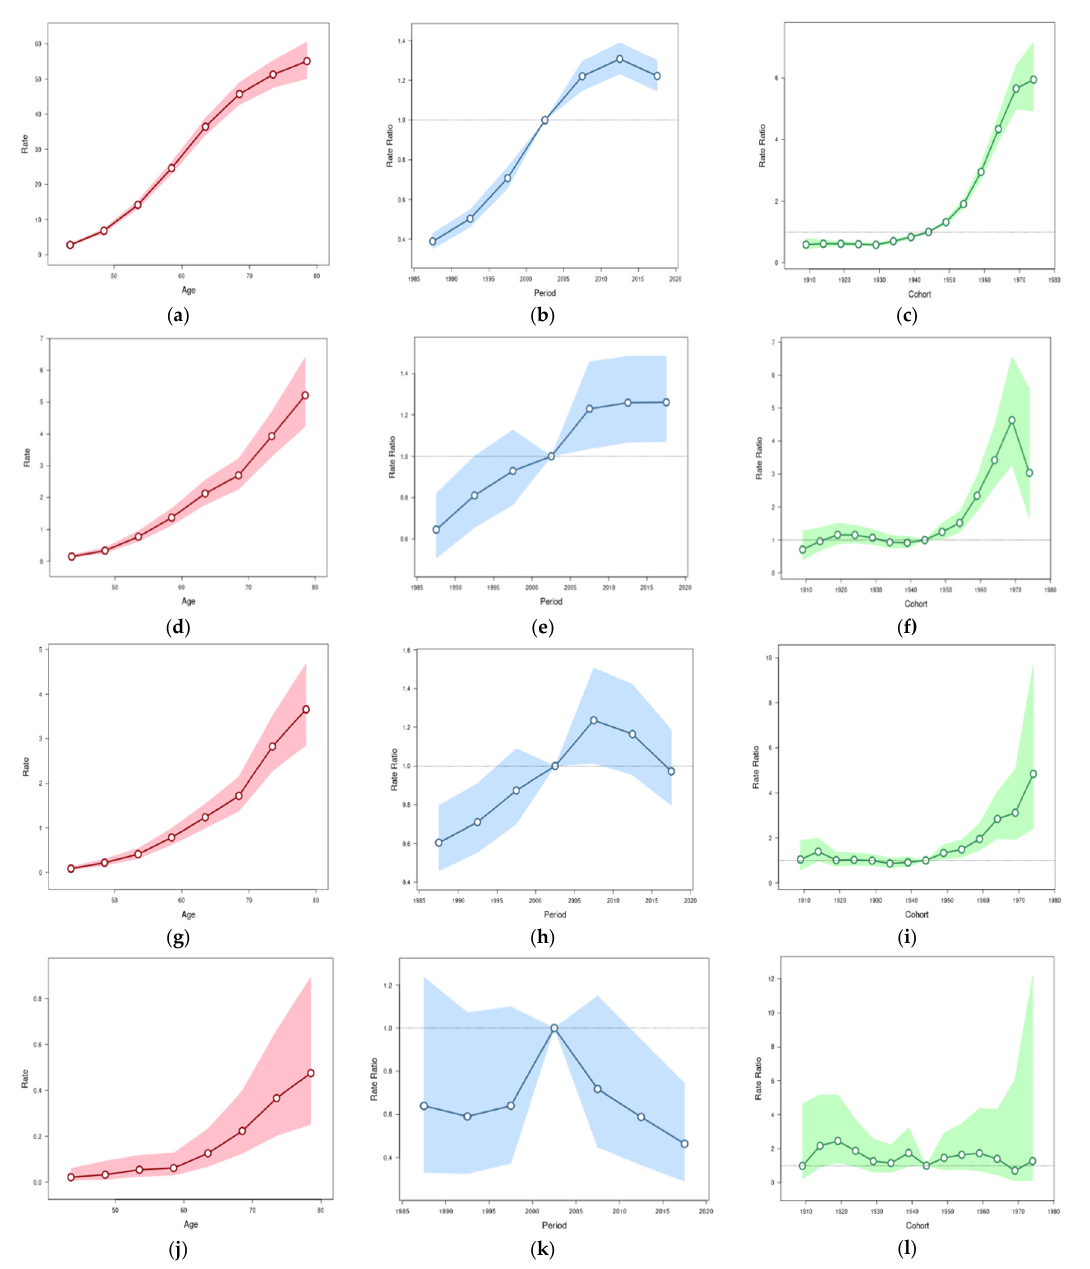
Figure 4. Age, period, and cohort effects of esophageal squamous cell carcinoma (ESCC) and adenocarcinoma (EAC) in Taiwan by sex. Age: 40–80 years old; period: 1985–2019; cohort: 1905–1974. The shadow indicates the 95% confidence interval. ( a – c ) Age, period, and cohort effects of ESCC in men; ( d – f ) age, period, and cohort effects of ESCC in women; ( g – i ) age, period, and cohort effects of EAC in men; ( j – l ) age, period, and cohort effects of EAC in